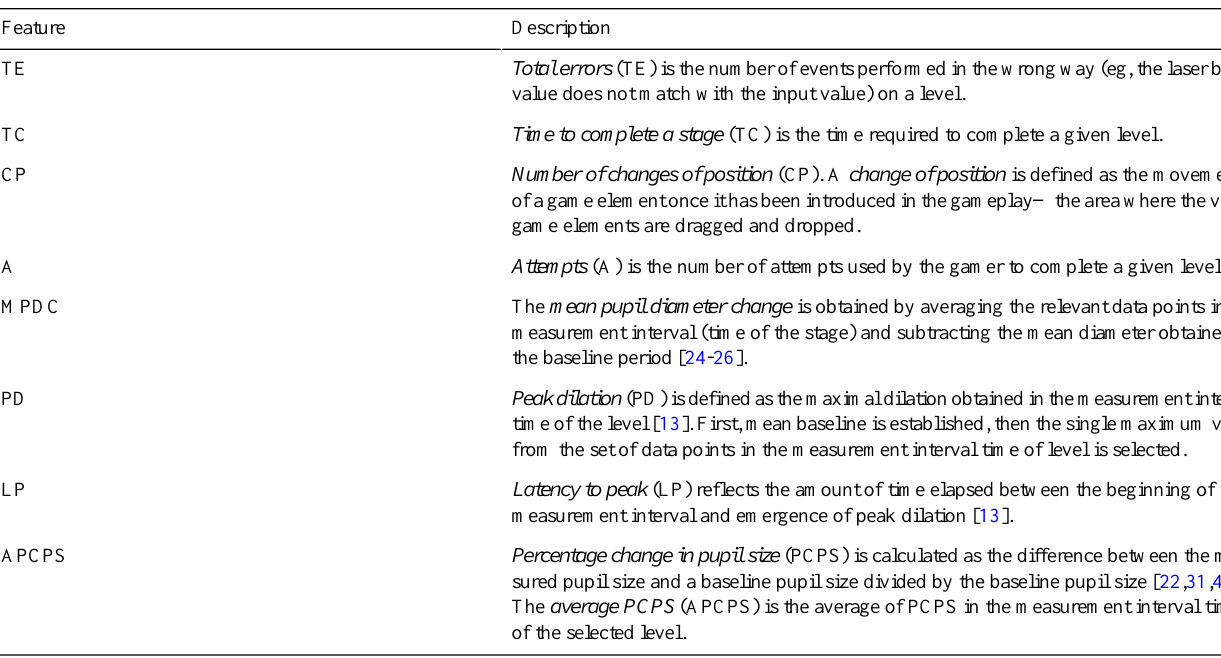
Table 2. Pupillary and gamer features studied in this experiment.